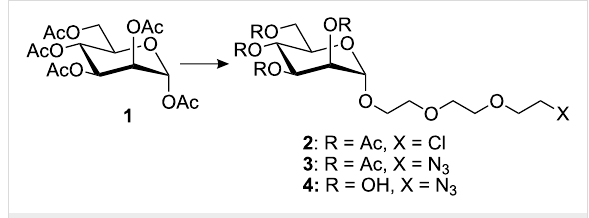
Figure 1: Preparation of the 8-azido-3,6-dioxaoctyl α -D- mannopyranoside.